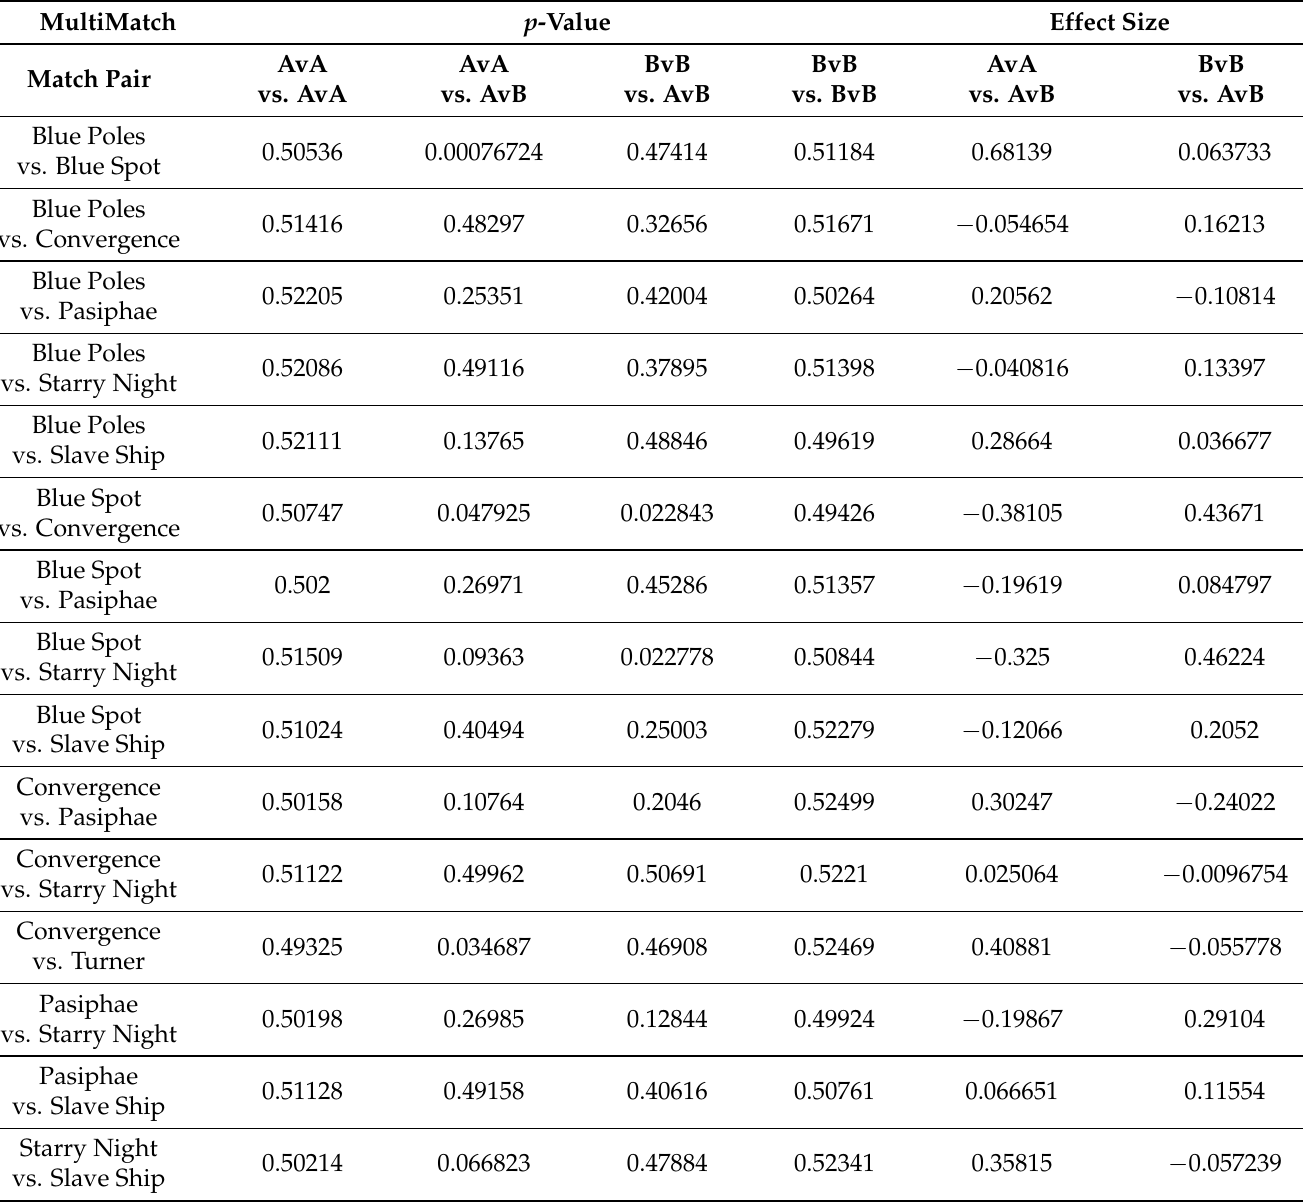
Table A4. MultiMatch direction results. Match pair (e.g., Blue Poles vs. Blue Spot), where AvA, AvB, and BvB represents a match score based on a comparison of the one member of the pair with itself, or the first member of the pair ( A ) (e.g., Blue Poles) and the second member, B (e.g., Blue Spot). The effect size for (AvA vs. AvA) and (BvB vs. BvB) in all cases was